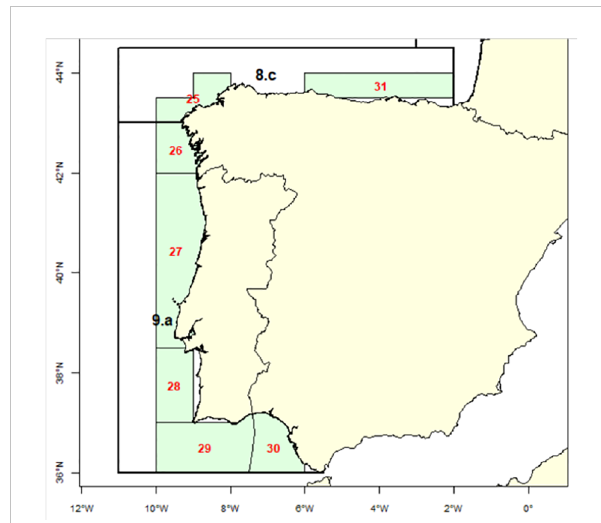
FIGURE 1 Location of Nephrops Functional Unit 26-27 (West Galicia and North Portugal, Division 9a), FU 25 (North Galicia) and FU 31 (Cantabrian Sea) (Division 8c) (ICES,